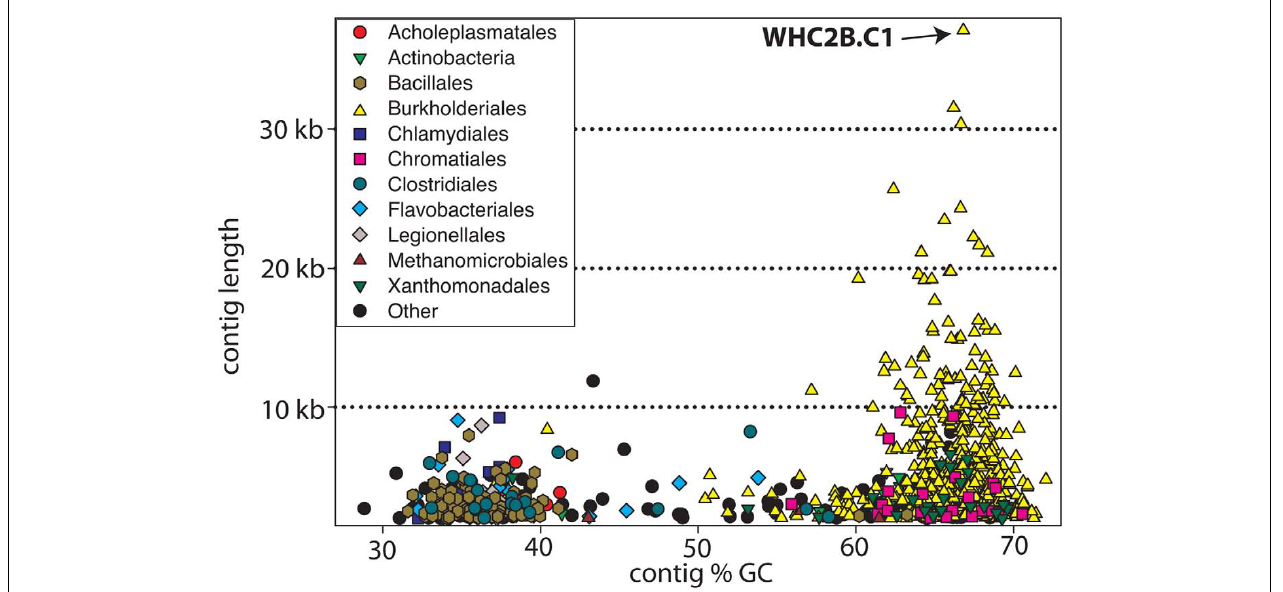
assembly. Most of the smaller contigs have low %GC, and many of these are assigned to Gram-positive bacteria including Bacillales and Clostridiales. Only contigs > 2kb are shown.